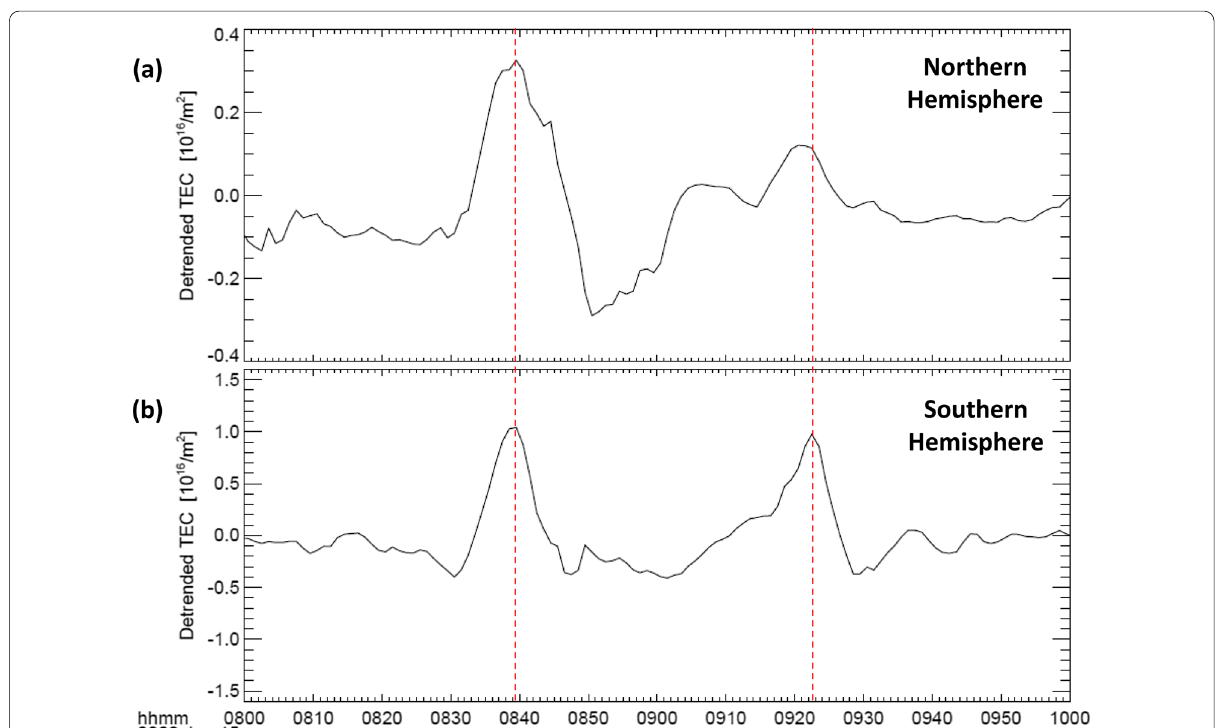
Fig. 3 Time-series plots ( a ) and ( b ) of detrended TEC at (43.0 o S, 140.0 o E) and the magnetic conjugate point in the Southern Hemisphere. The 2.0 o . The vertical dotted red lines indicate the peak value of detrended TEC at the detrended TEC values are averaged in a latitude range of ± magnetic conjugate